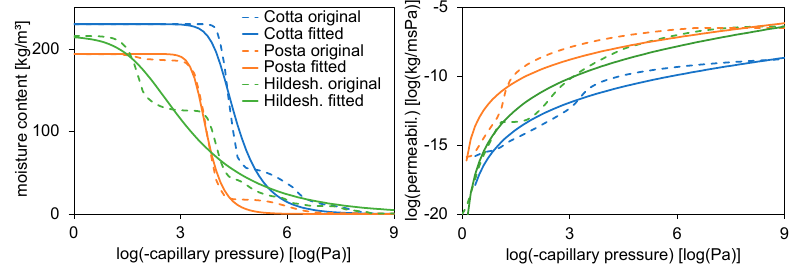
Figure 5. ( left ) Original (from Delphin material database) versus van Genuchten-Mualem-fitted moisture retention curves for three sandstones; ( right ) original (from Delphin material database) and van Genuchten-Mualem-fitted liquid permeability curves for three sandstones. A second fallacy of [1]’s hygric property description regards vapour permeability; see Equation (3). Predictions of the vapour permeability at 25%RH based on this equation yielded values of 5.4 × 10 − 11 , 4.2 × 10 − 11 , and 4.7 × 10 − 11 kg/msPa for the Cotta, Posta, Hildes- heim sandstones, respectively. Measurements in the Delphin material database provided values of 1.0 × 10 − 11 , 1.2 × 10 − 11 , and 1.4 × 10 − 11 kg/msPa, respectively—roughly 3–5 factors lower.